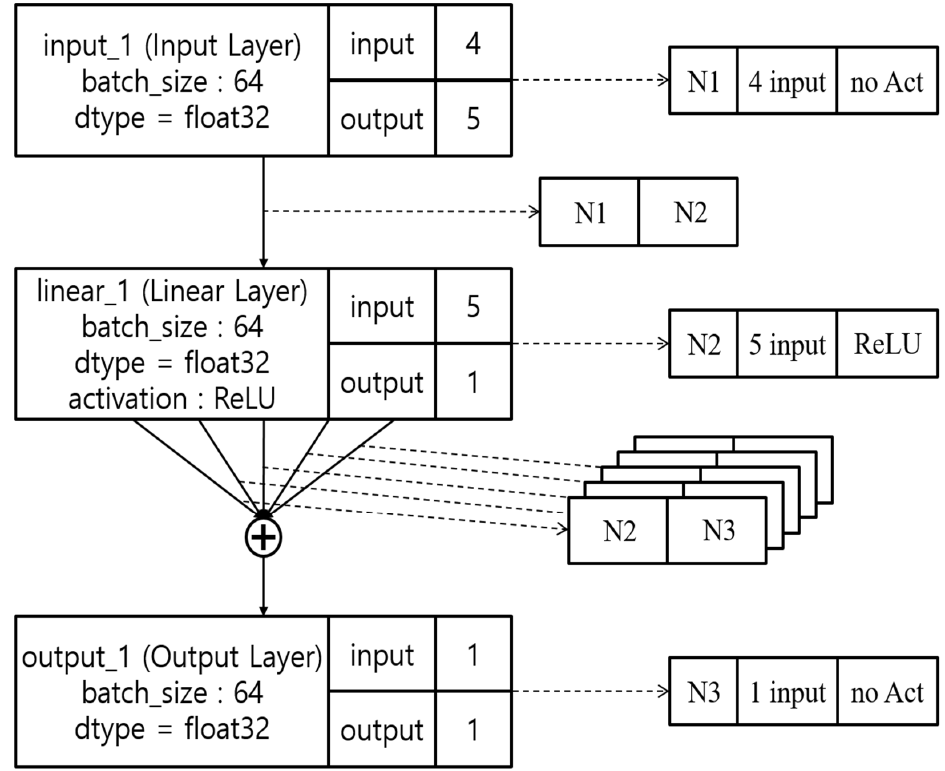
Figure 5. Final architecture of experiment.